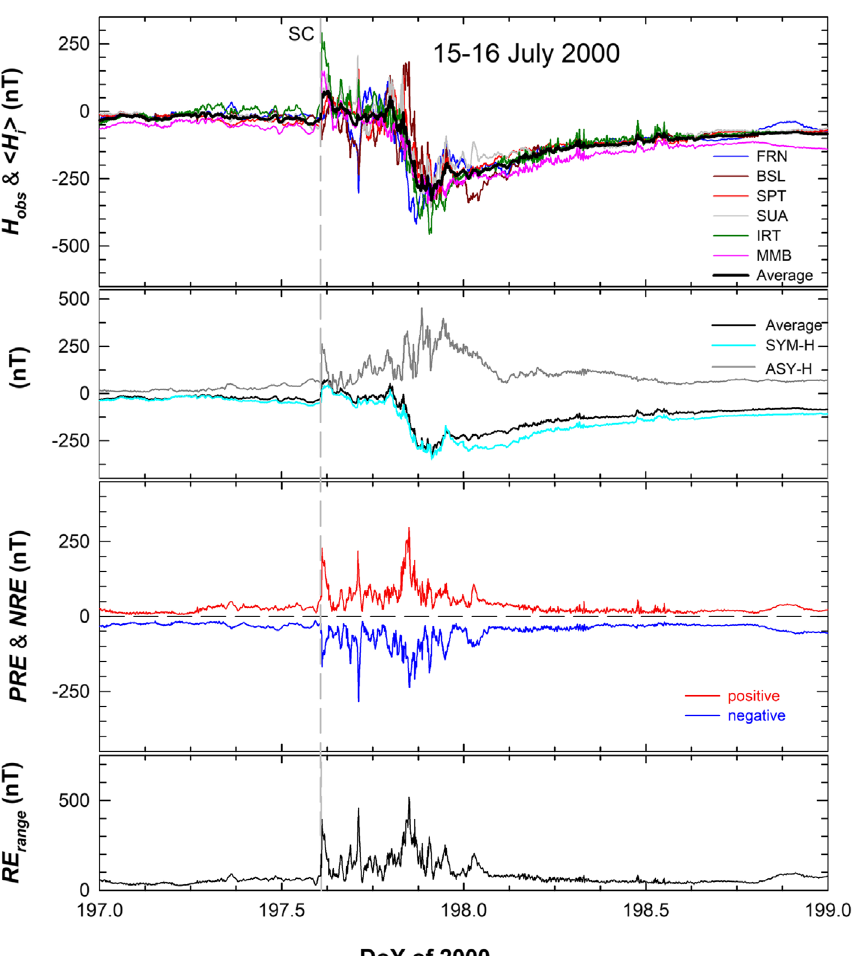
Fig. 7. The event on 15 – 16 July 2000 (event #2). Top panel: Magnetic disturbance, H obs , at the six mid-latitude observatories (in colors) and the average of the disturbance, h H i i (in black); Second panel: h H i i (in black), SYM-H index (in cyan) and ASY-H index (in dark gray); Third panel: Positive (red) and Negative (blue) Residual Envelopes; Bottom panel: Residual range obtained as the difference between the Positive and Negative Residual Envelopes. Grey dashed line marks the SSC in the period